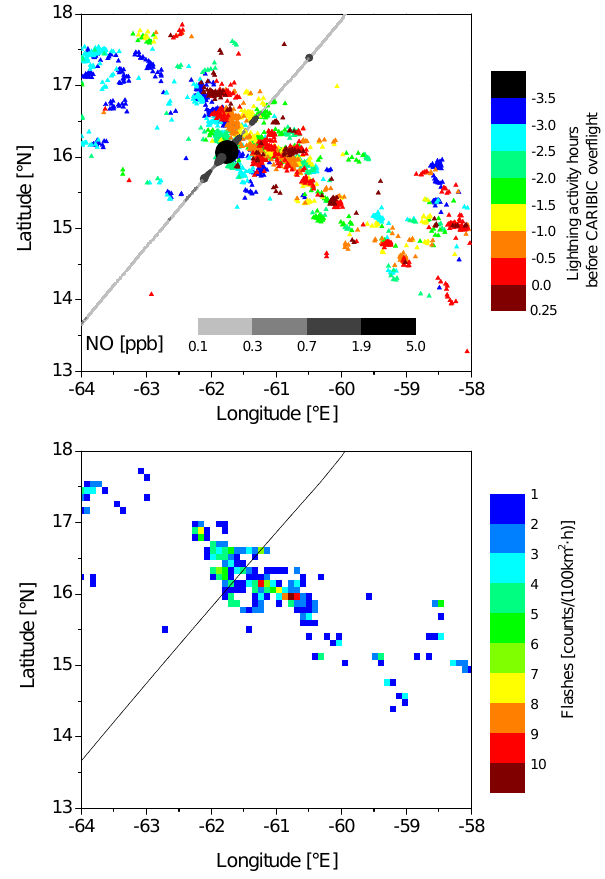
Figure 5. Top: Flashes (one point per registered flash) accord- ing to World Wide Lightning Location Network (http://wwlln.net) colour coded with the time difference to the CARIBIC overflight (18:26UTC). To illustrate the ongoing activity also the next 15min after CARIBIC penetrated the cloud are included. The grey line il- lustrates the CARIBIC flight track colour coded with the 10s aver- aged NO data. The maximum NO is observed on the edge (south- west) of the lightning activity area. Bottom: flash density in flashes per 100km 2 and hour for the last 3.5h prior to the CARIBIC over- pass. The detection efficiency of 18% is not considered in this fig-